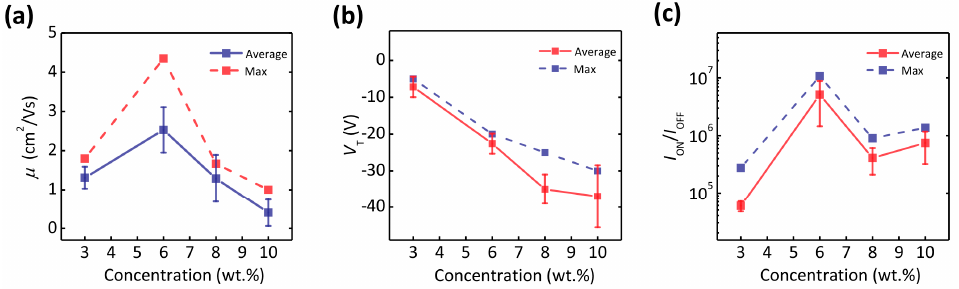
Figure 3. ( a – c ) Dependence relationship of the field-effect characteristic parameters: mobility ( µ ), threshold voltage ( V T ), and on/off current ratio ( I ON / I OFF ), on the concentration of the PVA solution.